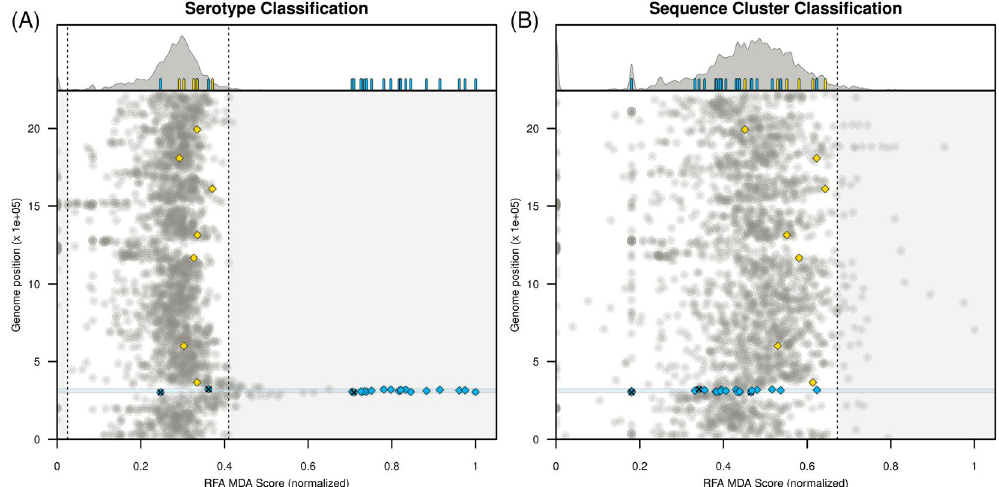
Figure 1. Random forest classification. ( A ) Random forest analysis (RFA) for serotype classification. ( A , top ) Density function of RFA scores obtained for each gene in the dataset. The 95% boundaries are marked by the dashed lines. Small bars highlight the RFA scores of genes within particular groups (yellow for MLST genes, blue for capsular locus genes). ( A , bottom ) Genomic position for each gene in the dataset against their RFA score (normalised to [0,1]). The circular genome is presented in a linear form on the y-axis, with the first gene being dnaA and the last gene parB . MLST genes are marked in yellow diamonds ( spi, xpt, glkA, aroE, ddlA, tkt ) and genes within the capsular locus with blue diamonds (pseudogenes tagged with ‘x’). ( B ) RFA analysis for sequence cluster classification; figure details the same as in A . Blue shaded areas in both A and B subplots mark the capsular locus (genes within aliA and dexB